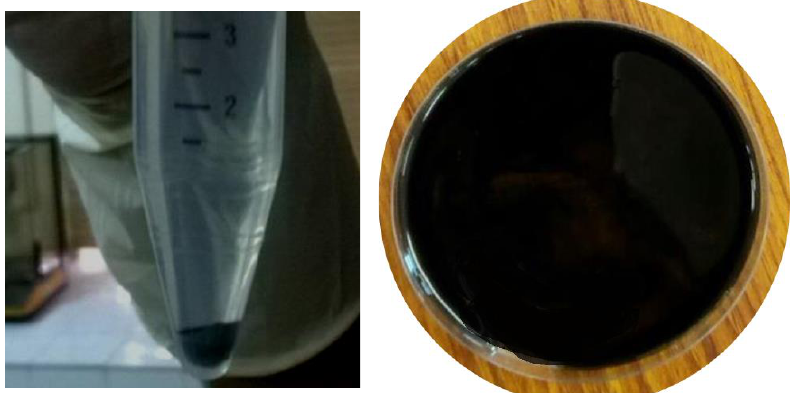
Figure 3. Ag-NPs after centrifugations ( left ). Silver nanoparticle ink dispersed in ethylene glycol ( right ).